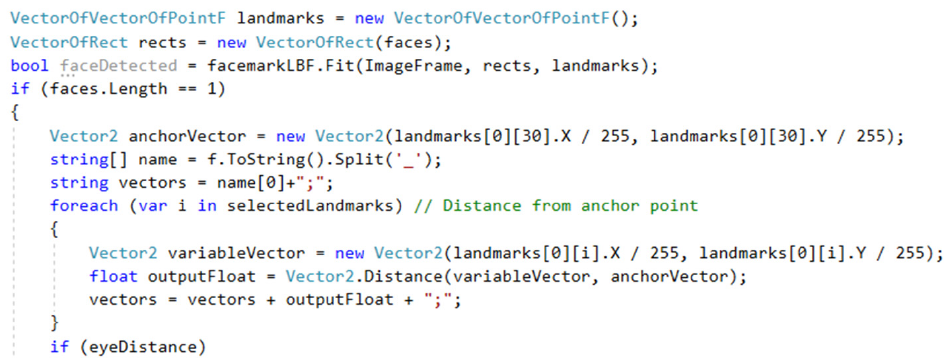
Figure 6. Sample of the function for extracting facial features (own creation).